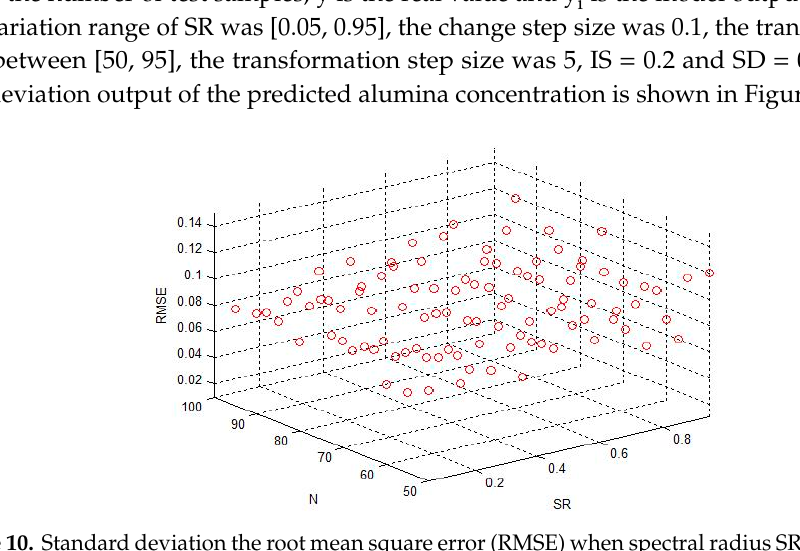
Figure 10. Standard deviation the root mean square error (RMSE) when spectral radius SR and reservoir size N change.